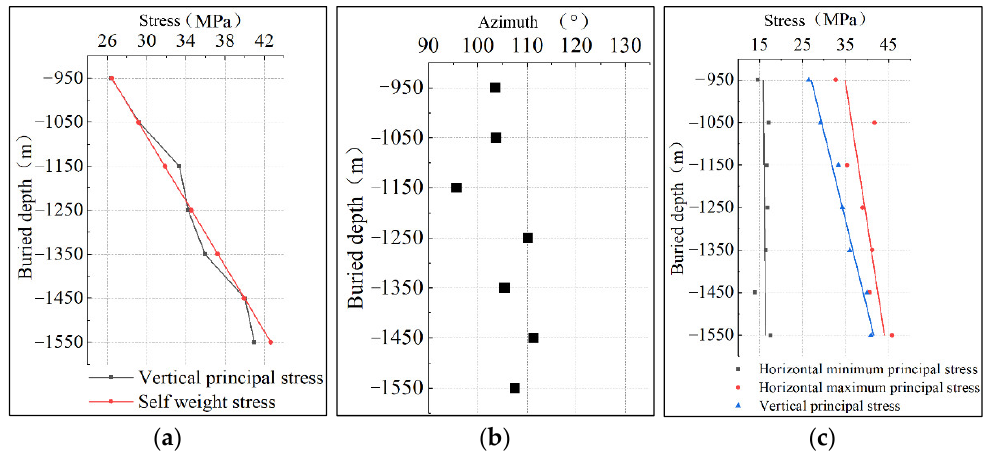
Figure 8. Distribution of in situ stress: ( a ) vertical principal stress; ( b ) azimuth; ( c ) horizontal principal stress.